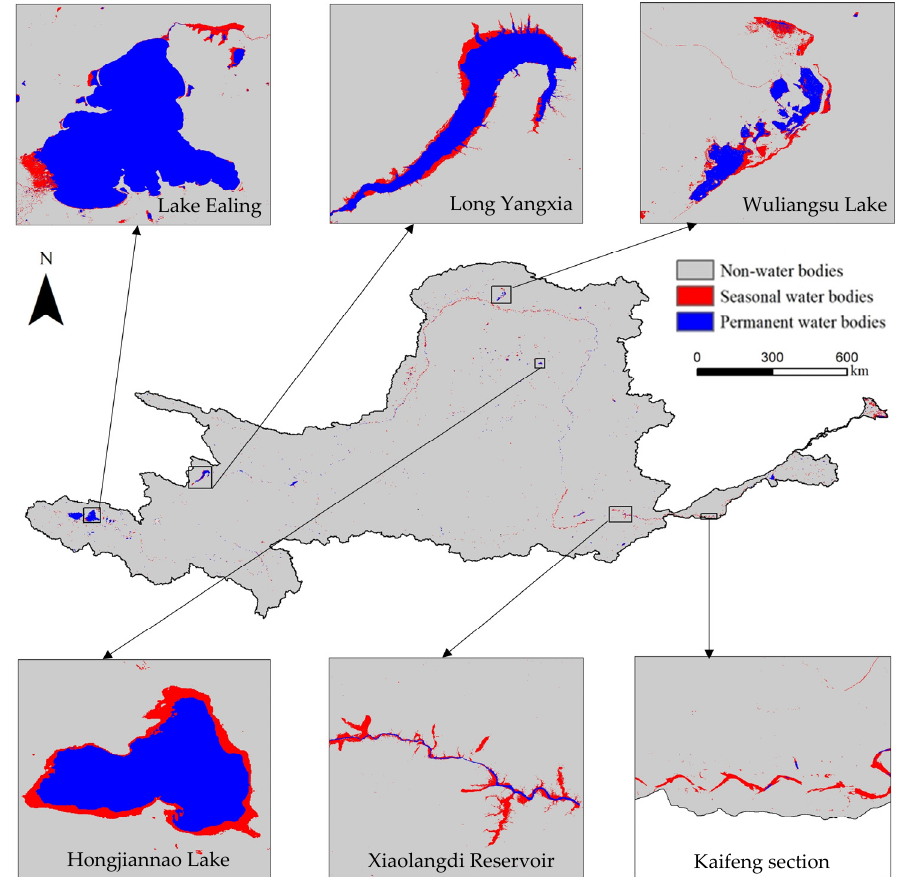
Figure 6. The spatial distribution of the surface water bodies derived from the multi-year average WIF during 1986–2019.